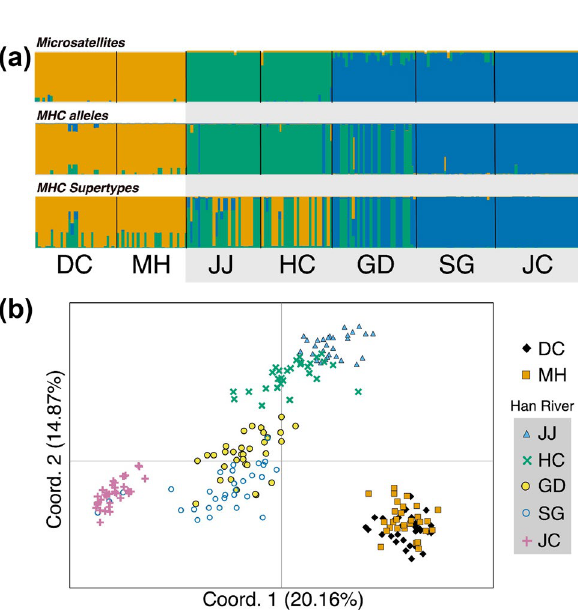
Figure 3. ( a ) Population genetic structure of Rhodeus pseudosericeus estimated from microsatellite genotyping and MHC allelic and supertypic data. The population structure estimated in Structure using the most reliable number of clusters predicted by delta K method ( K = 3 for all three; see Supplementary Fig. S1). ( b ) Bi-dimensional plot of the principal component analysis (PCA) showing genetic differentiation based on microsatellite pairwise- F ST values among seven populations of R. pseudosericeus from the Korean Peninsula. See Table 1 or Fig. 1 for locality codes. The population IDs of the Han River were shaded in the